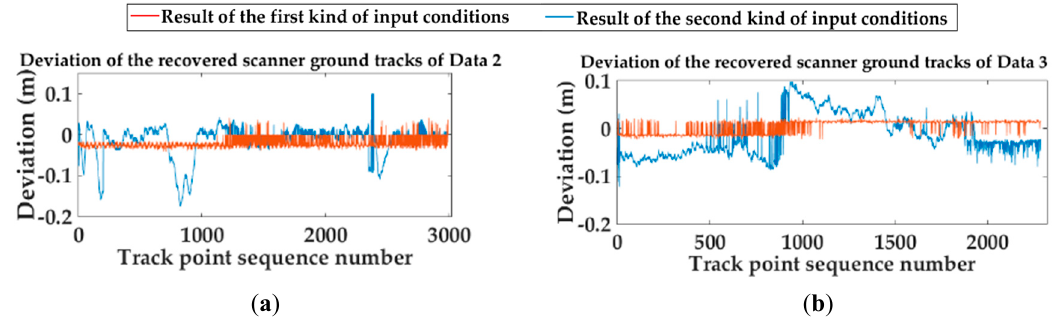
Figure 15. Comparison of the recovered ground tracks of the scanner with the true value. ( a ) Data 3. ( b ) Data 2.